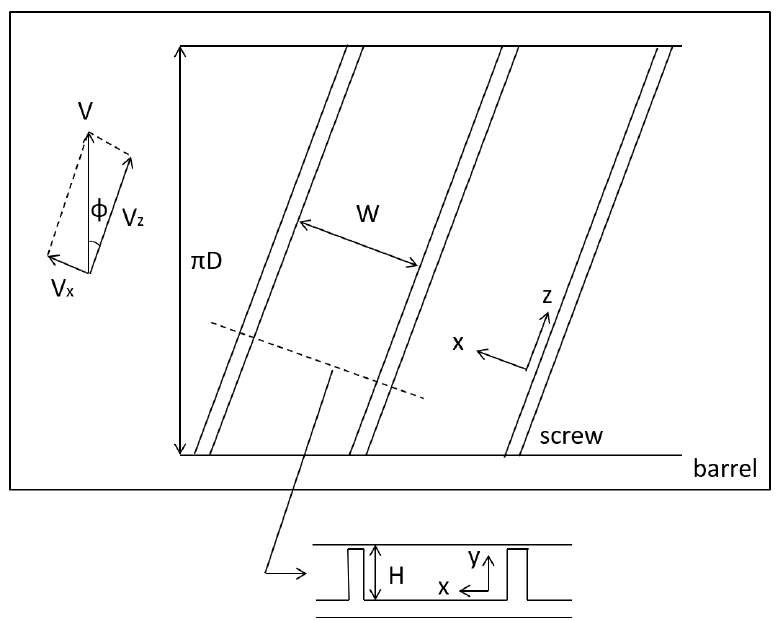
Figure 1. Geometry of unwound screw and barrel in single screw